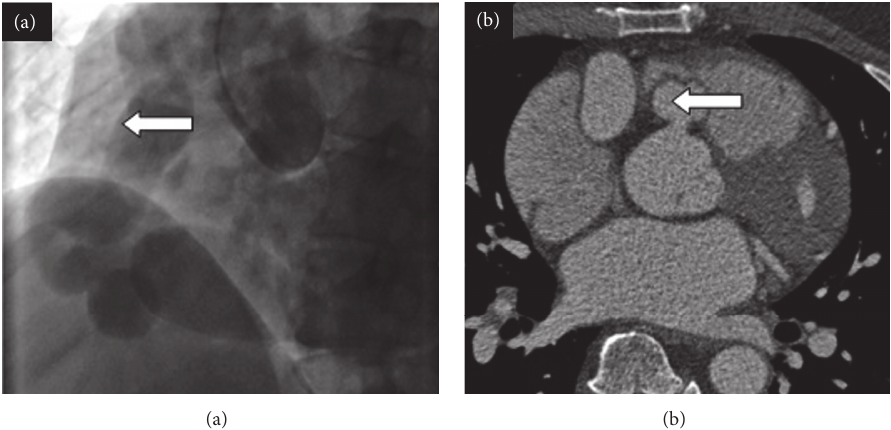
Figure 1: (a) Coronary angiogram demonstrating the aneurysmal right coronary artery on right coronary injection (arrow). (b) Computed tomography (CT) coronary angiogram showing the aneurysmal right coronary artery arising from the normal position on the aorta (arrow).